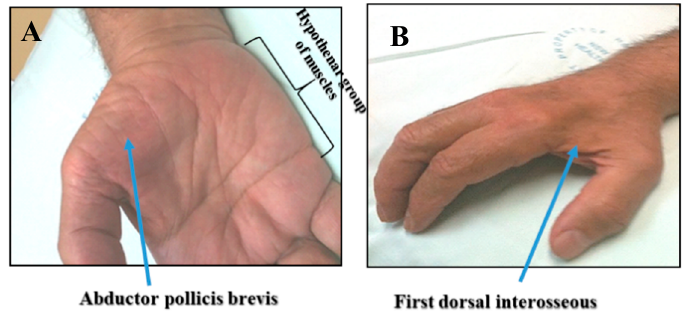
Figure 3. Dissociated muscle atrophy is a specific feature of ALS, characterized by preferential wasting of the ( A ) abductor pollicis brevis and ( B ) first dorsal interosseous muscles, when compared to the hypothenar group of muscles.